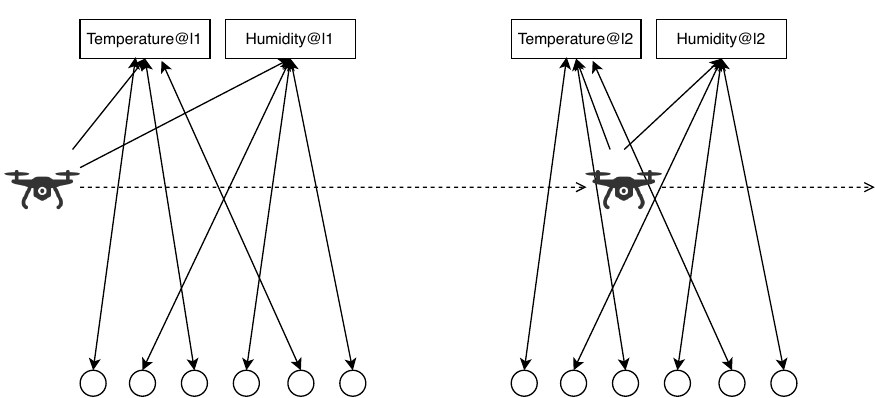
Figure 8. How the drone join and leave different semantic matches for data fusion, belief updating and fault detection in different